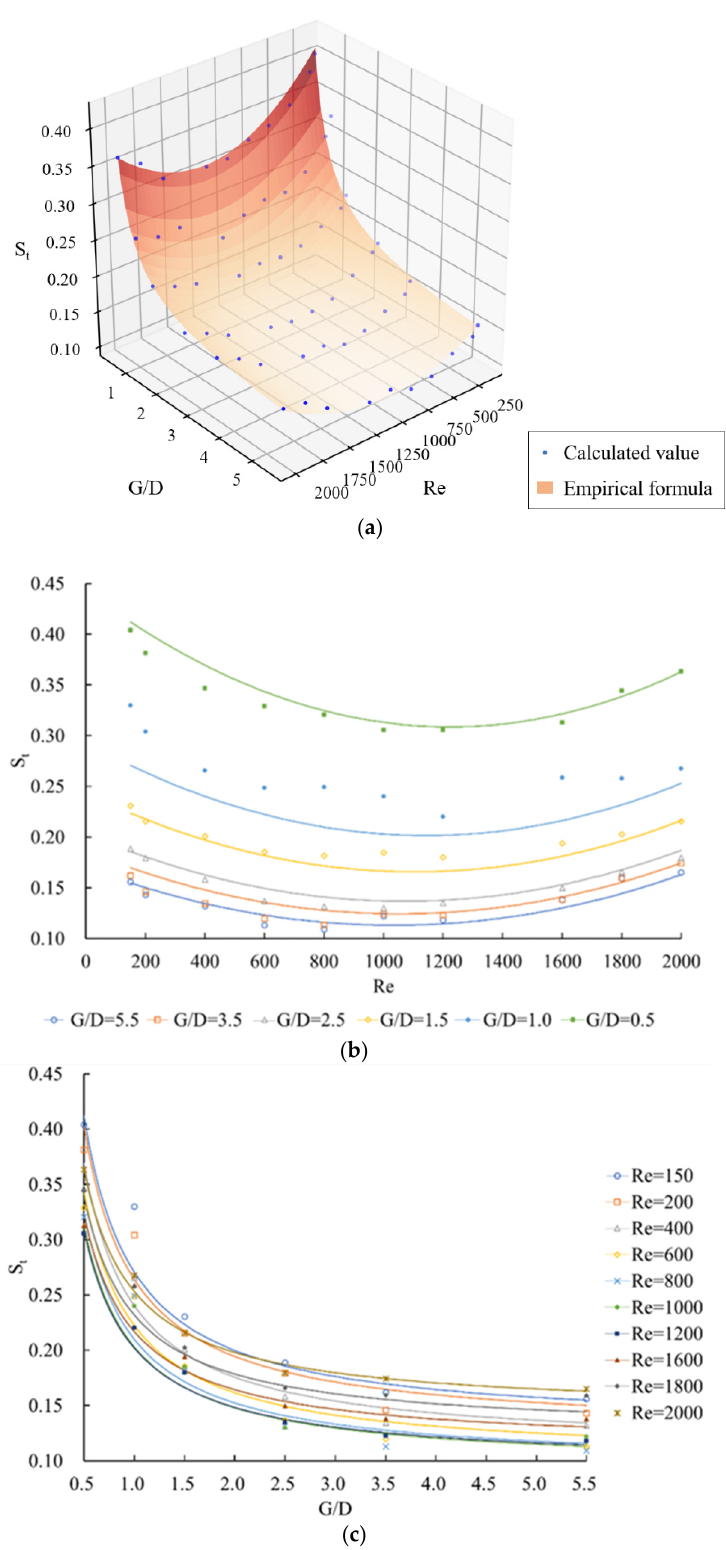
Figure 10. Relationship of 𝐶 (cid:3031) (cid:3364)(cid:3364)(cid:3364) and G / D , 𝑅 (cid:3032) . ( a ) 𝑙𝑛𝐶 (cid:3031) (cid:3364)(cid:3364)(cid:3364) versus 𝑙𝑛𝑅𝑒 and 𝐺 𝐷 ⁄ ; ( b ) 𝐶 (cid:3031) (cid:3364)(cid:3364)(cid:3364) versus 𝐺 𝐷 ⁄ ; and ( c ) 𝑙𝑛𝐶 (cid:3031) (cid:3364)(cid:3364)(cid:3364) versus 𝑙𝑛𝑅𝑒 .